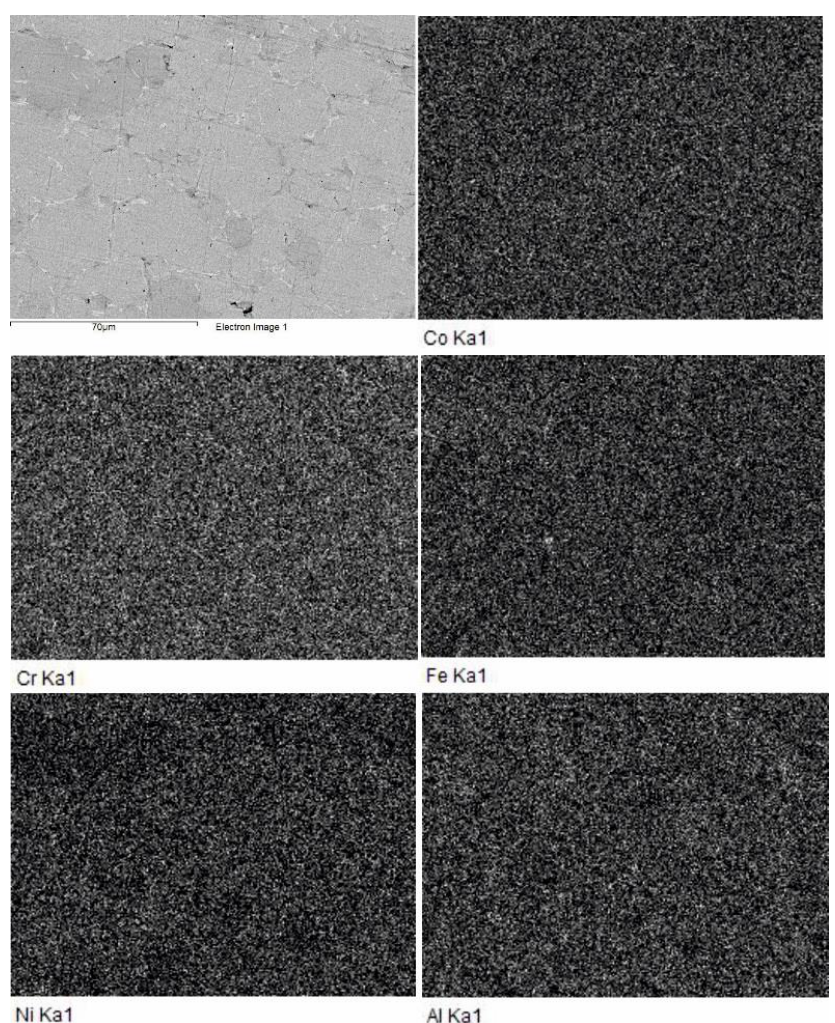
Figure 6. SEM image (upper left) and X-ray mapping of the elements for a sample SPS-consolidated at 800 °C.